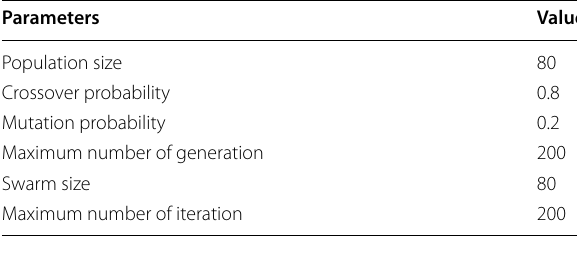
Table 3 Optimization algorithm super-parameter